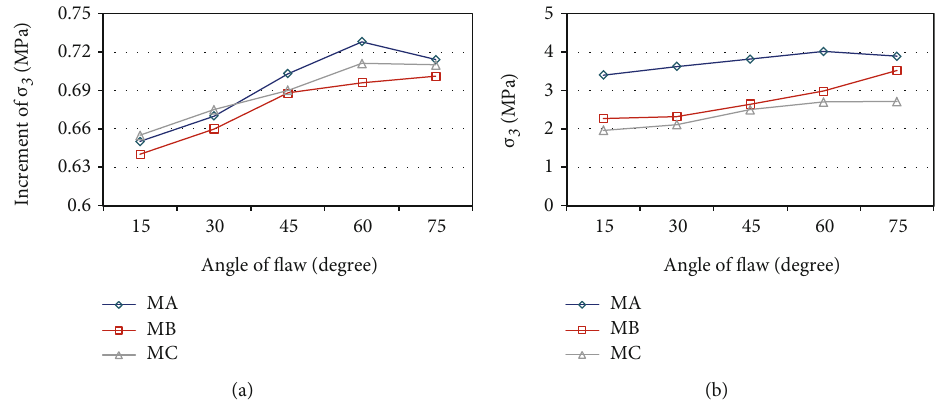
σ 3 and 3 by monitoring points: (a) incremental tensile stress; (b) total tensile stress.